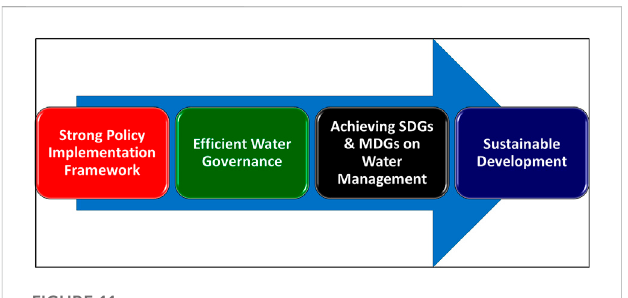
FIGURE 11 Proposed policy framework.